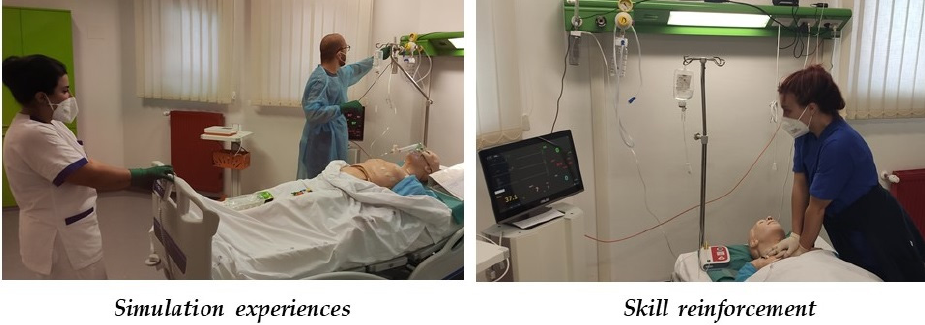
Figure 2. Students during simulation sessions and skill reinforcement.